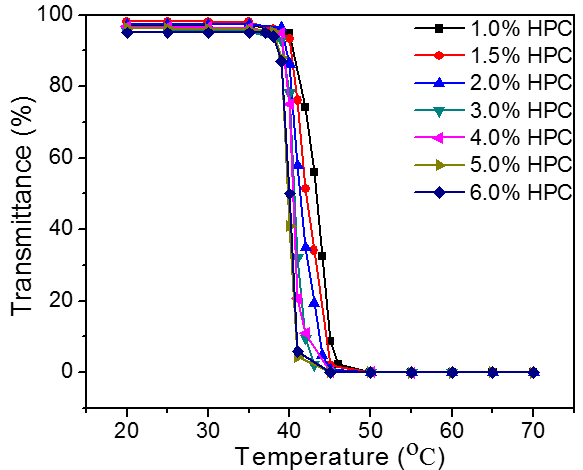
Figure 4. The thermal and optical behaviour of the selected wt. %’s HPC in aqueous solution at spectra of 600 nm.